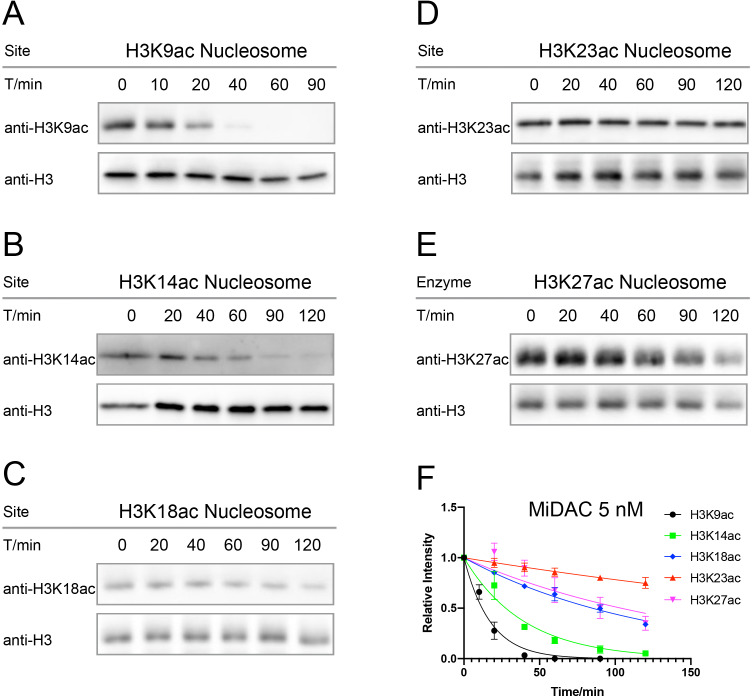
Typical results for Western-blot based deacetylation activity assay with 5 nM MiDAC on different nucleosomes with site-specific acetylation.(A) nucleosome with H3K9ac, n = 2, V/E = 1.2 ± 0.19 min−1; (B) nucleosome with H3K14ac, n = 3, V/E = 0.52 ± 0.034 min−1; (C) nucleosome with H3K18ac, n = 2, V/E = 0.17 ± 0.0051 min−1; (D) nucleosome with H3K23ac, n = 4, V/E = 0.048 ± 0.0071 min−1; (E) nucleosome with H3K27ac, n = 5, V/E = 0.18 ± 0.036 min−1, and (F) the curve fitting for kinetics analysis.